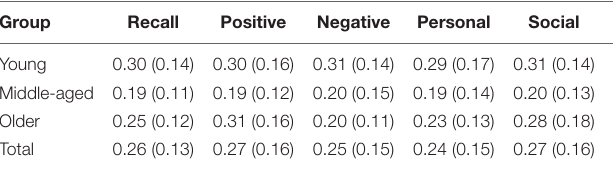
TABLE 2 | Mean proportion (SD) of correct recall depending on their valence (positive and negative) and nature (personal, social), in the different age groups.